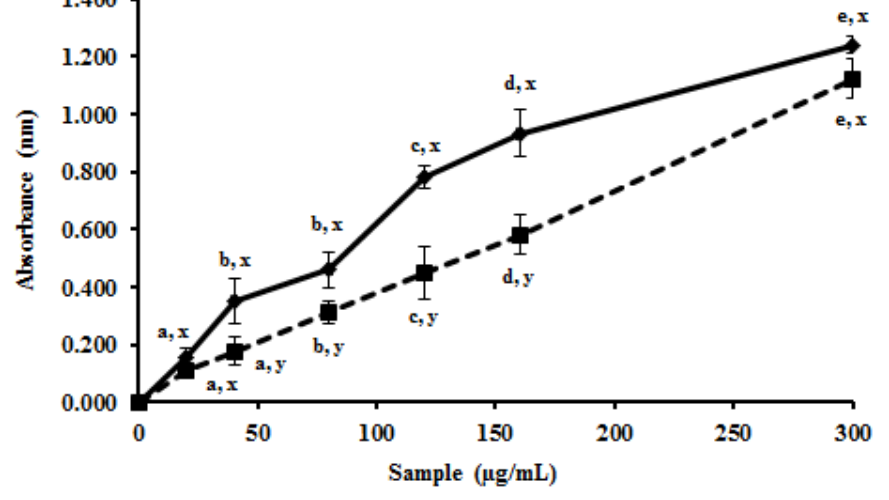
acid). MEC and ascorbic acid were used in the follow concentrations 0; 20; 40; 80; 120; 160; 300 µg/mL. a,b,c,d,e Indicate significantly differences between different concentrations of the same sample. x,y Represent significantly difference between different samples